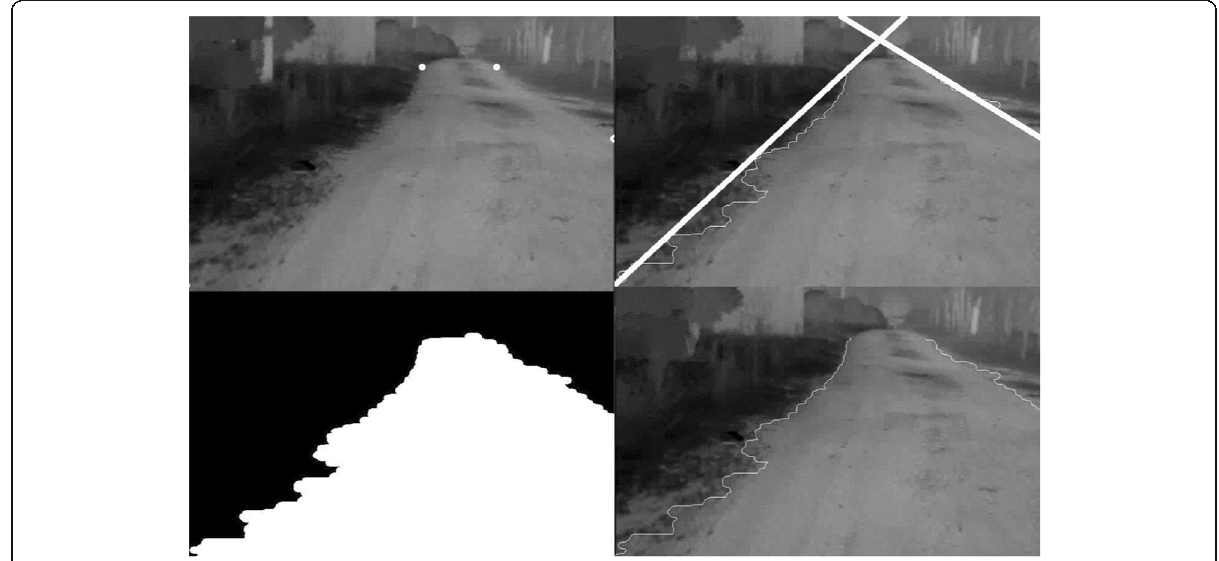
Fig. 4 Trapezoid forecasting model. a Trapezoid vertex figure. b Trapezoid region. c Judged road area map. d Road boundary